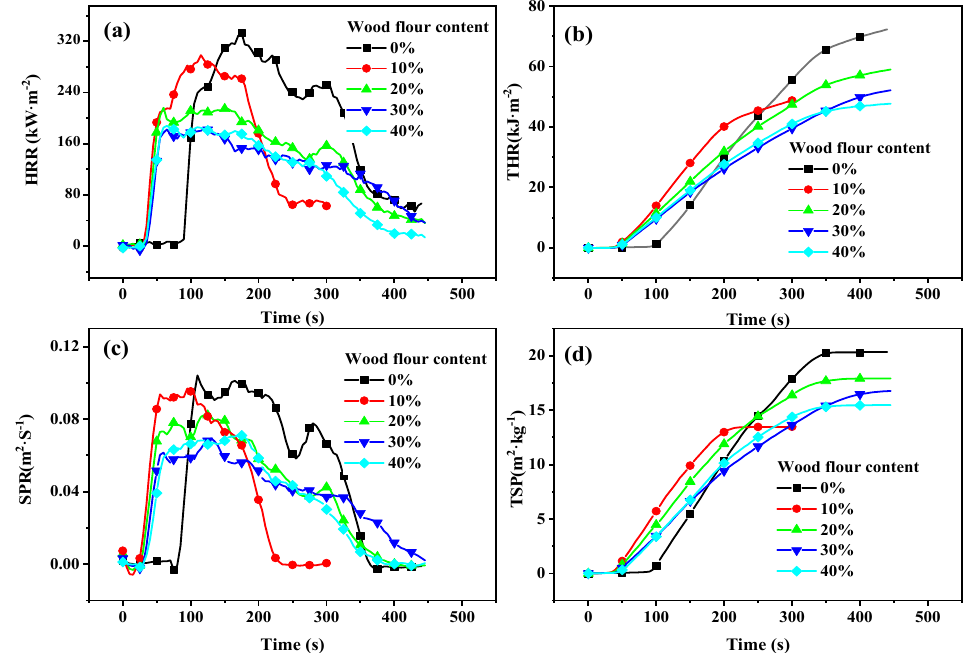
Figure 1. Heat rate release (HRR) ( a ), total heat release (THR); ( b ), smoke production rate (SPR); ( c ), total smoke production (TSP); ( d ), and curves of wood-PC composites.